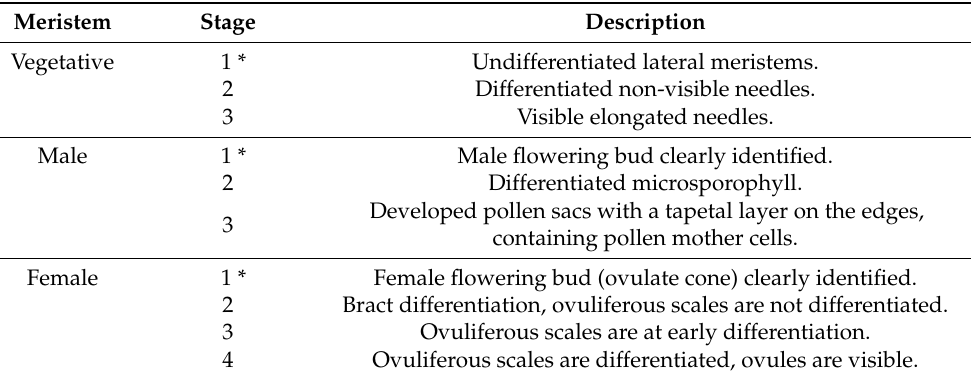
Table 1. Developmental stages of vegetative shoot, and male and female buds. Meristem Stage Description Vegetative 1 * Undifferentiated lateral